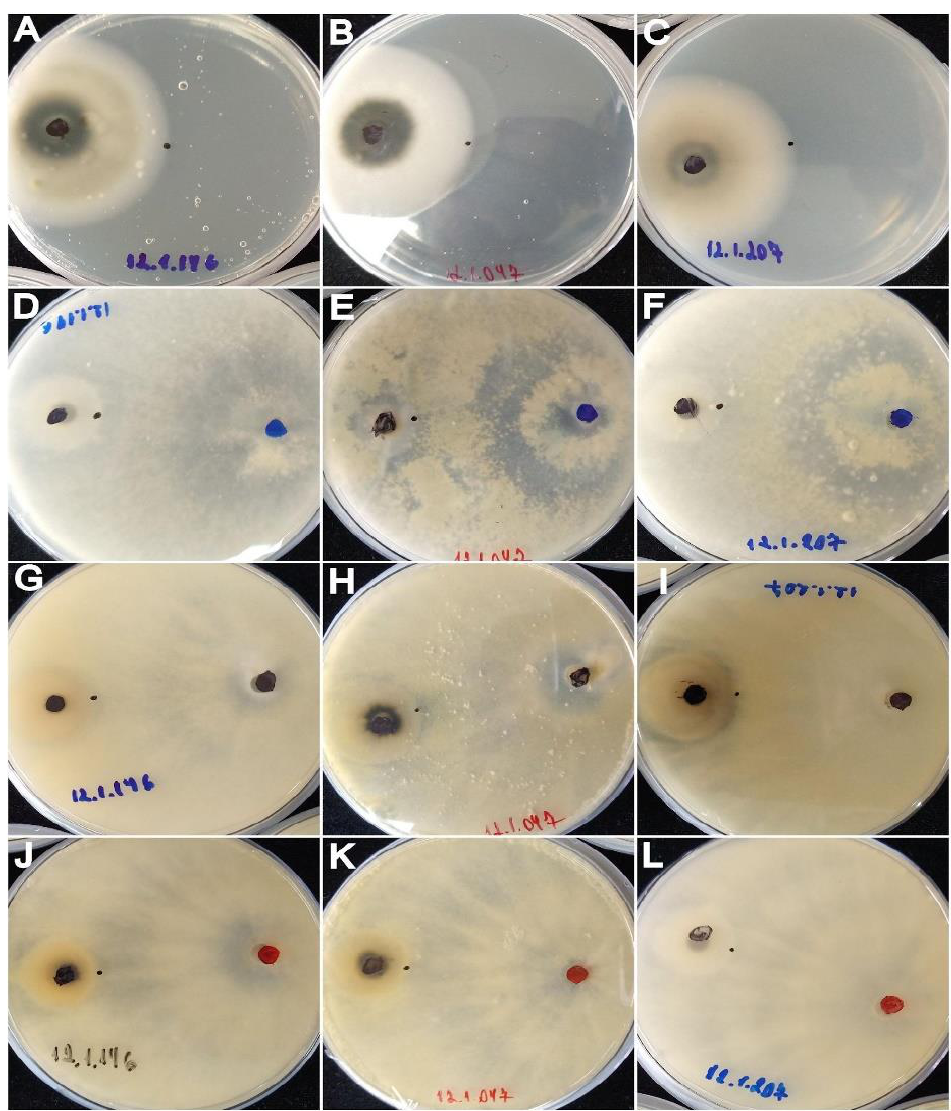
Figure 4. In vitro antagonism of Trichoderma species against Pyricularia oryzae Triticum lineage ( PoTl ). ( A – C ): PoTl isolates only (12.1.146, 12.1.047 and 12.1.207); ( D – F ): PoTl isolates paired with T. konin- giopsis ‘Cachara’; ( G – I ): PoTl isolates paired with T. virens ‘Jau’; ( J – L ): PoTl isolates paired with T. lentiforme